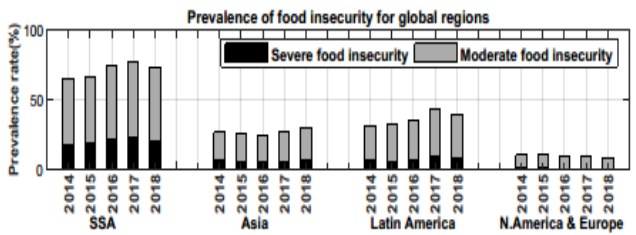
Figure 2. The global prevalence of food insecurity from 2014 to